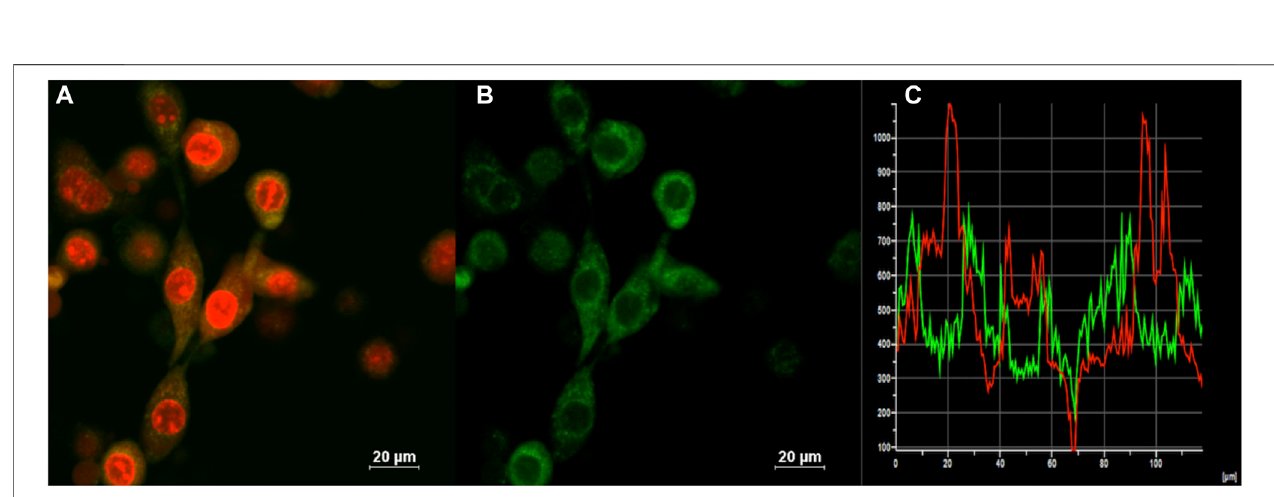
FIGURE 4 | CLSM images of (A) Merged image of all channels for the cells co-stained with a commercial nuclear stain RedDot ™ (1.0 μ M, 30 min) and probe; (B) (OMeTPA)2Pyr (2.0 μ M with 0.1% DMSO in cell medium) treated live Hela cells after 30 min staining; (C) Calculation of co-localization coef fi cient. Scale bar: 20 μ m.